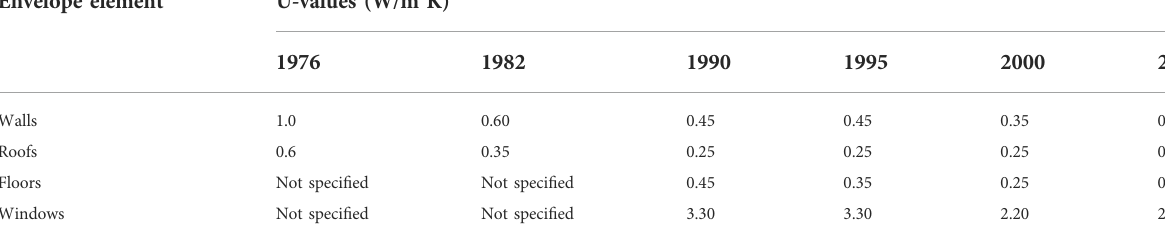
TABLE 1 U-values (W/m2K) in the United Kingdom building regulation (Urquizo et al., 2019). Envelope element